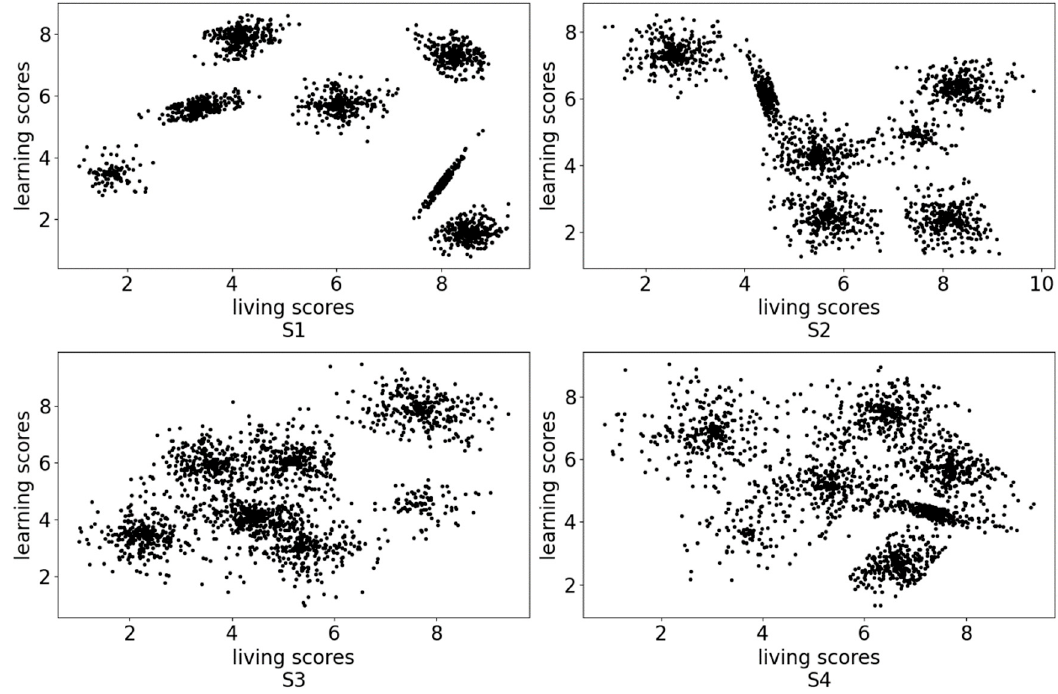
Figure 3. Data distribution scatter plot of 4 universities.